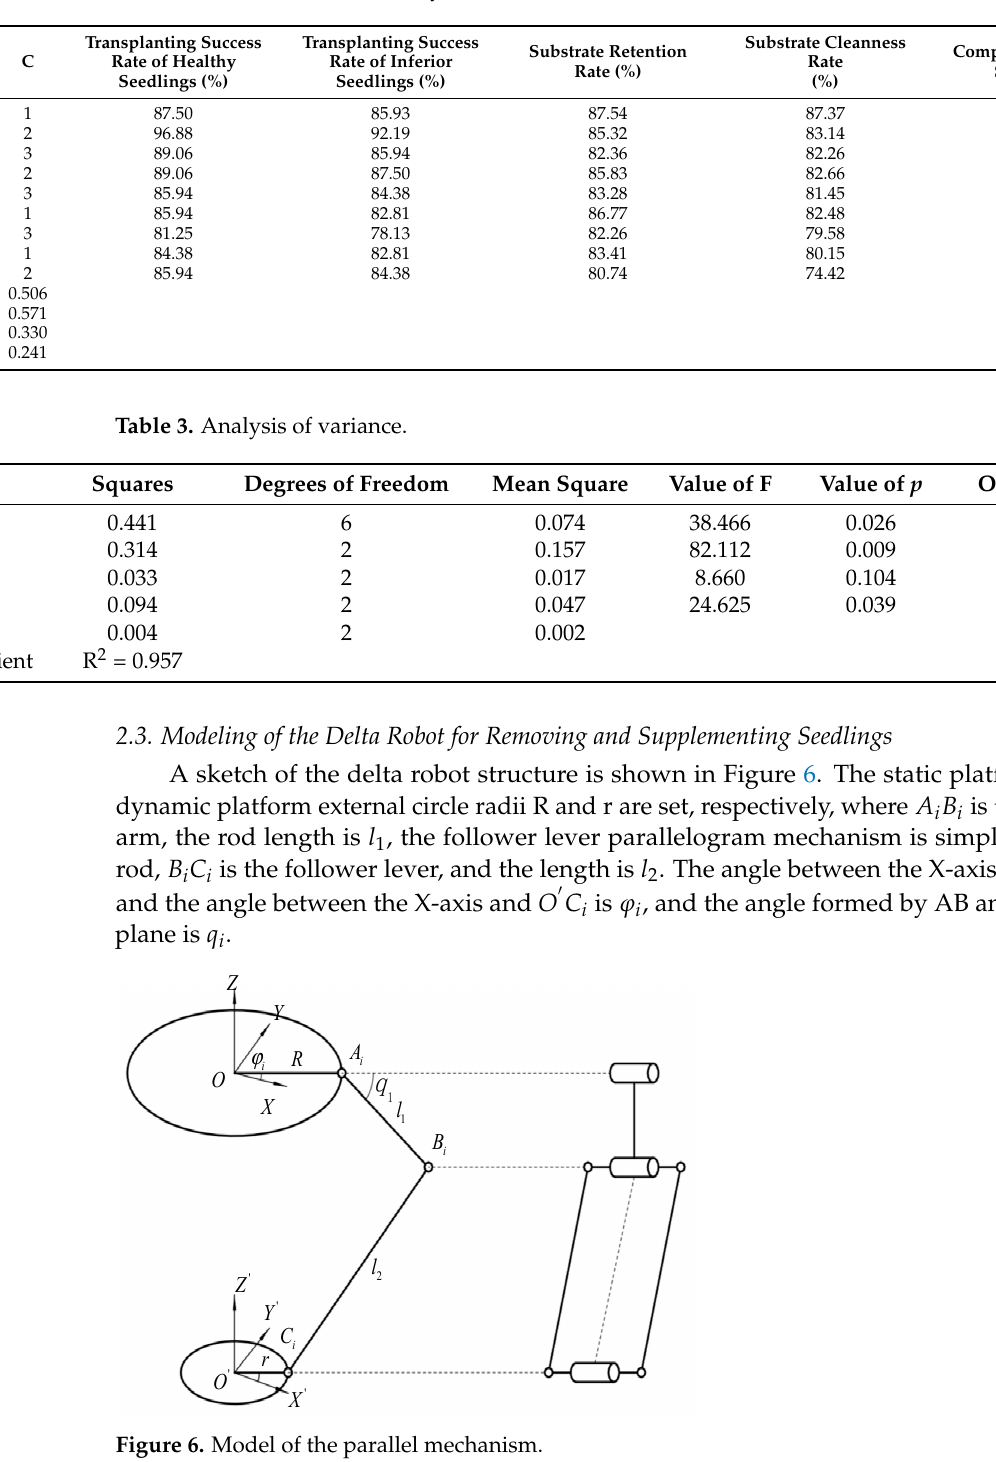
Table 2. Extreme deviation analysis.